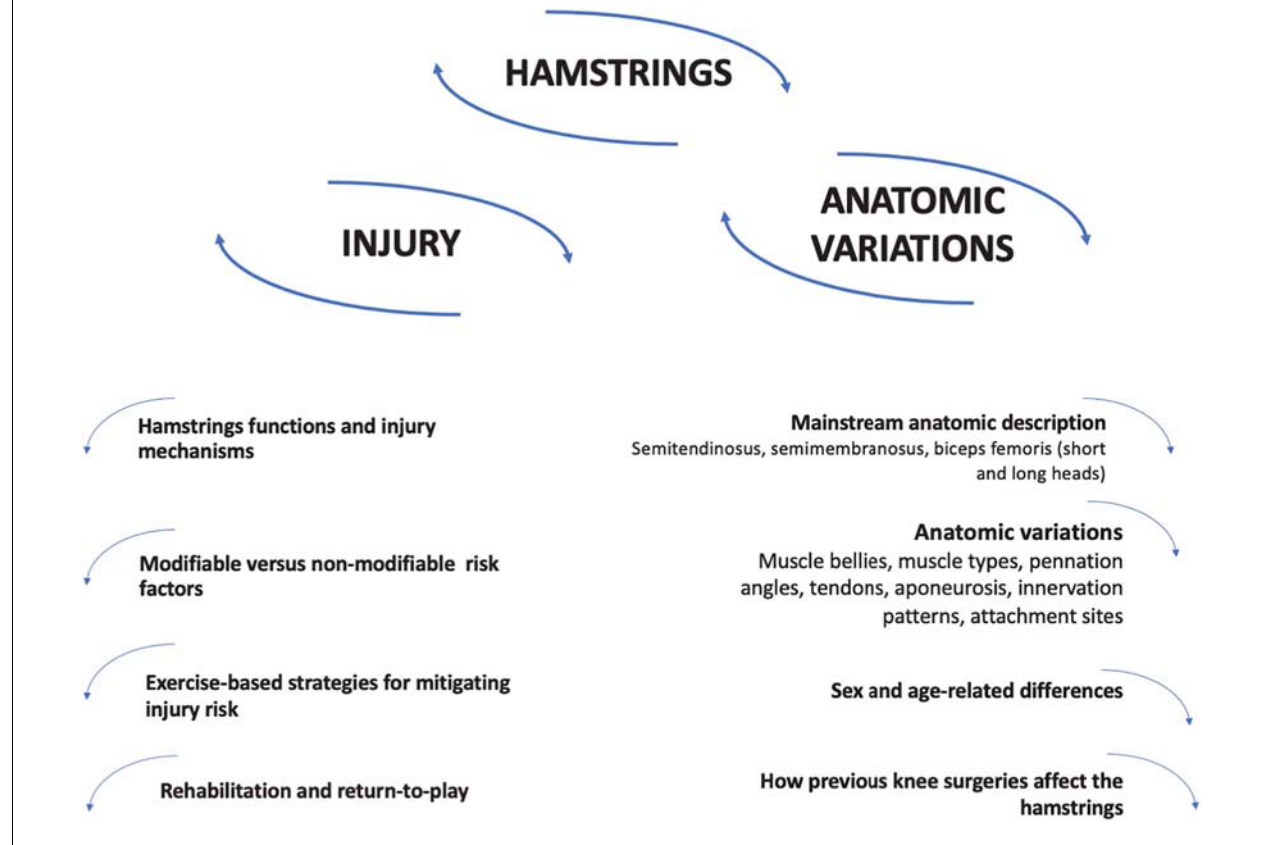
FIGURE 2 | Overview of concepts and hamstrings anatomic and physiologic